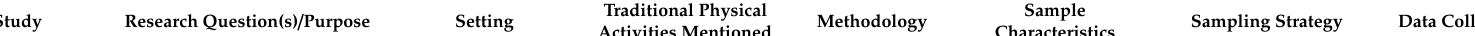
Table 1. Characteristics of studies included in systematic review of the impacts of traditional physical activities (PA) on Indigenous youth.